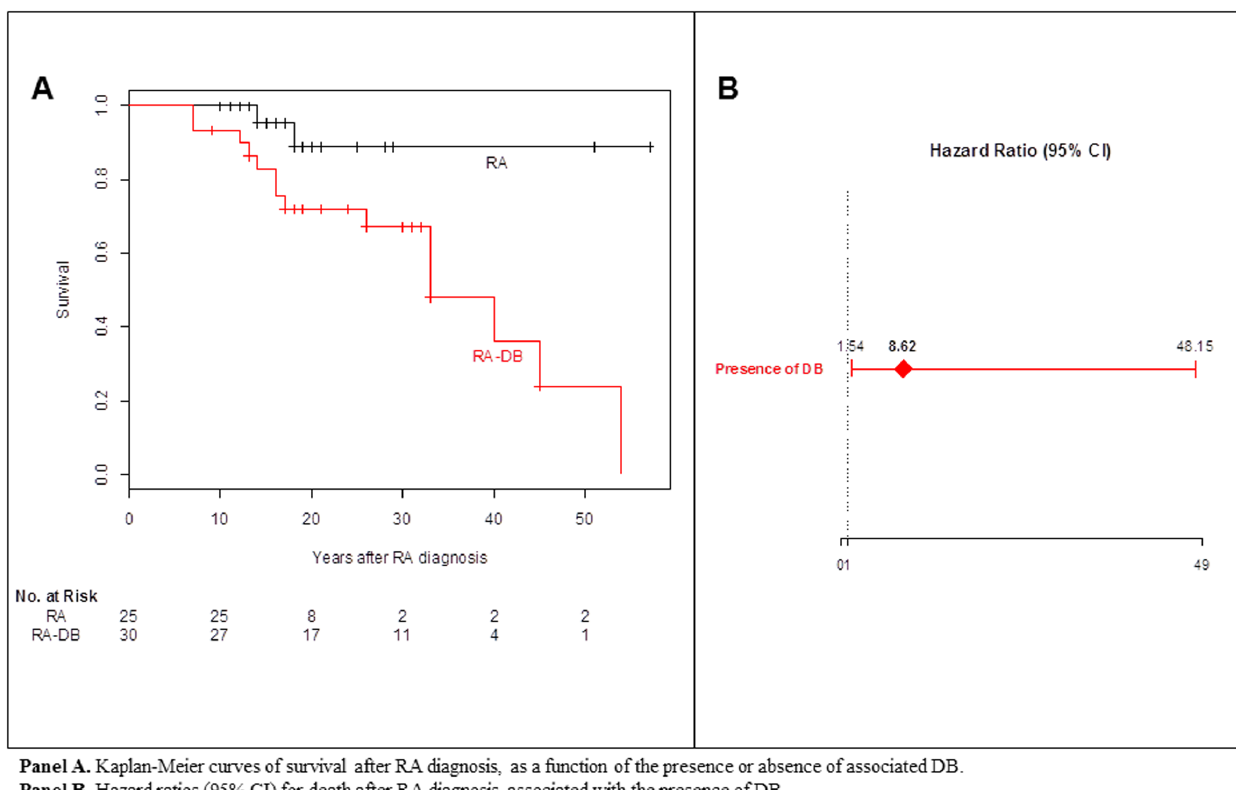
Figure 2. Kaplan-Meier probability of survival after RA diagnosis in patients, as a function of the presence or absence of associated DB. Panel A . Kaplan-Meier curves of survival after RA diagnosis, as a function of the presence or absence of associated DB. Panel B . Hazard ratios (95% CI) for death after RA diagnosis associated with the presence of DB. A mixed effect Cox model was fitted, taking RA diagnosis as the starting point. Individual random effects were assumed to be correlated as a function of the corresponding kinship coefficients. The variance of the random effect was 4 10 2 4 . RA: rheumatoid arthritis; DB: diffuse bronchiectasis.